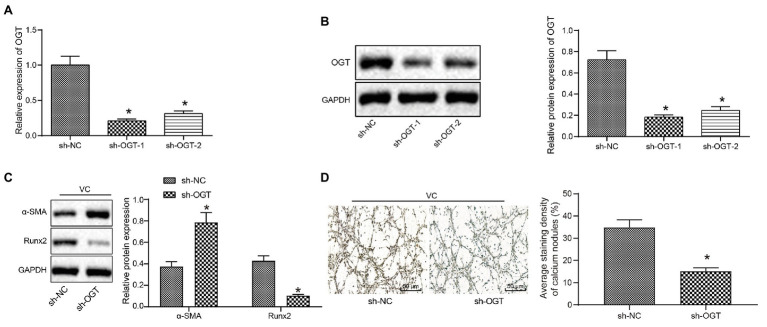
Silencing of OGT alleviates high phosphate-induced calcification in VSMCs. (A) Quantitative analysis for silencing efficiency of short hairpin RNAs (shRNAs) targeting OGT in VC cell models as detected by RT-qPCR. (B) Western blot analysis of OGT silencing efficiency of VC cell models normalized to GAPDH. (C) Western blot analysis of expression patterns of calcification-related proteins Runx2 and α-SMA normalized to GAPDH in response to OGT silencing. (D) Von Kossa staining and quantitative analysis showing calcium deposition in cell models. *p < 0.05 vs. cells transduced with shRNA negative control (sh-NC; in vitro experiments were repeated three times independently).